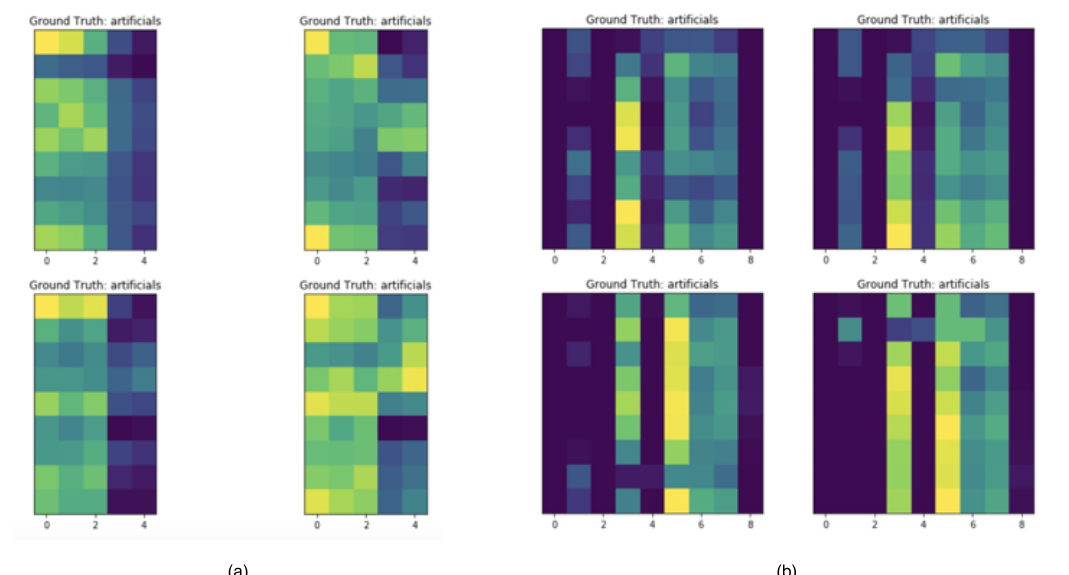
Figure 12. Visual representation of the activation of the internal neurons of Pixel R-CNN, where darker color are values close to zero and vice versa. ( a ). four samples of the same class “artificials”, ( b ). related activations inside the network at the output of the TimeDistributedDense layer Y ( timeD ) . It is interesting to notice how the four inputs are pretty different from each other, but the network representations already at this level are